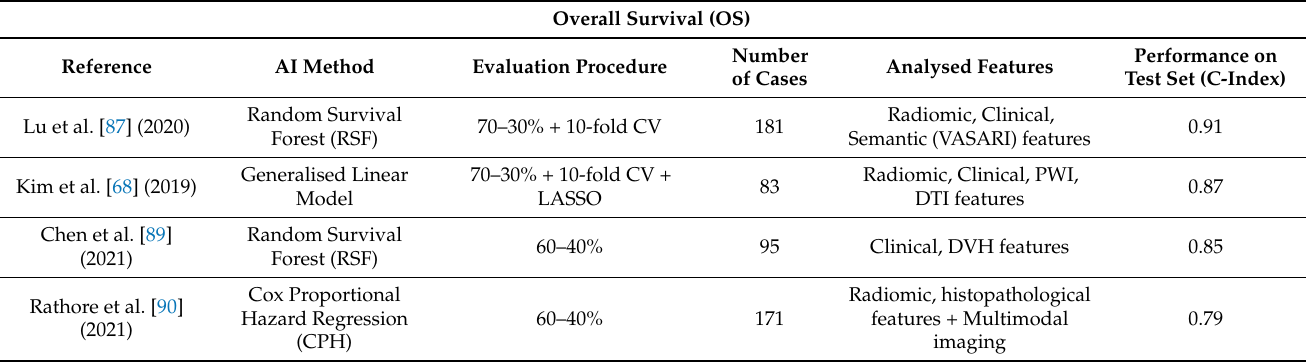
Table 1. Characteristics and performance (C-Index) of the four methods with the highest C-Index for Overall Survival (OS). Overall Survival